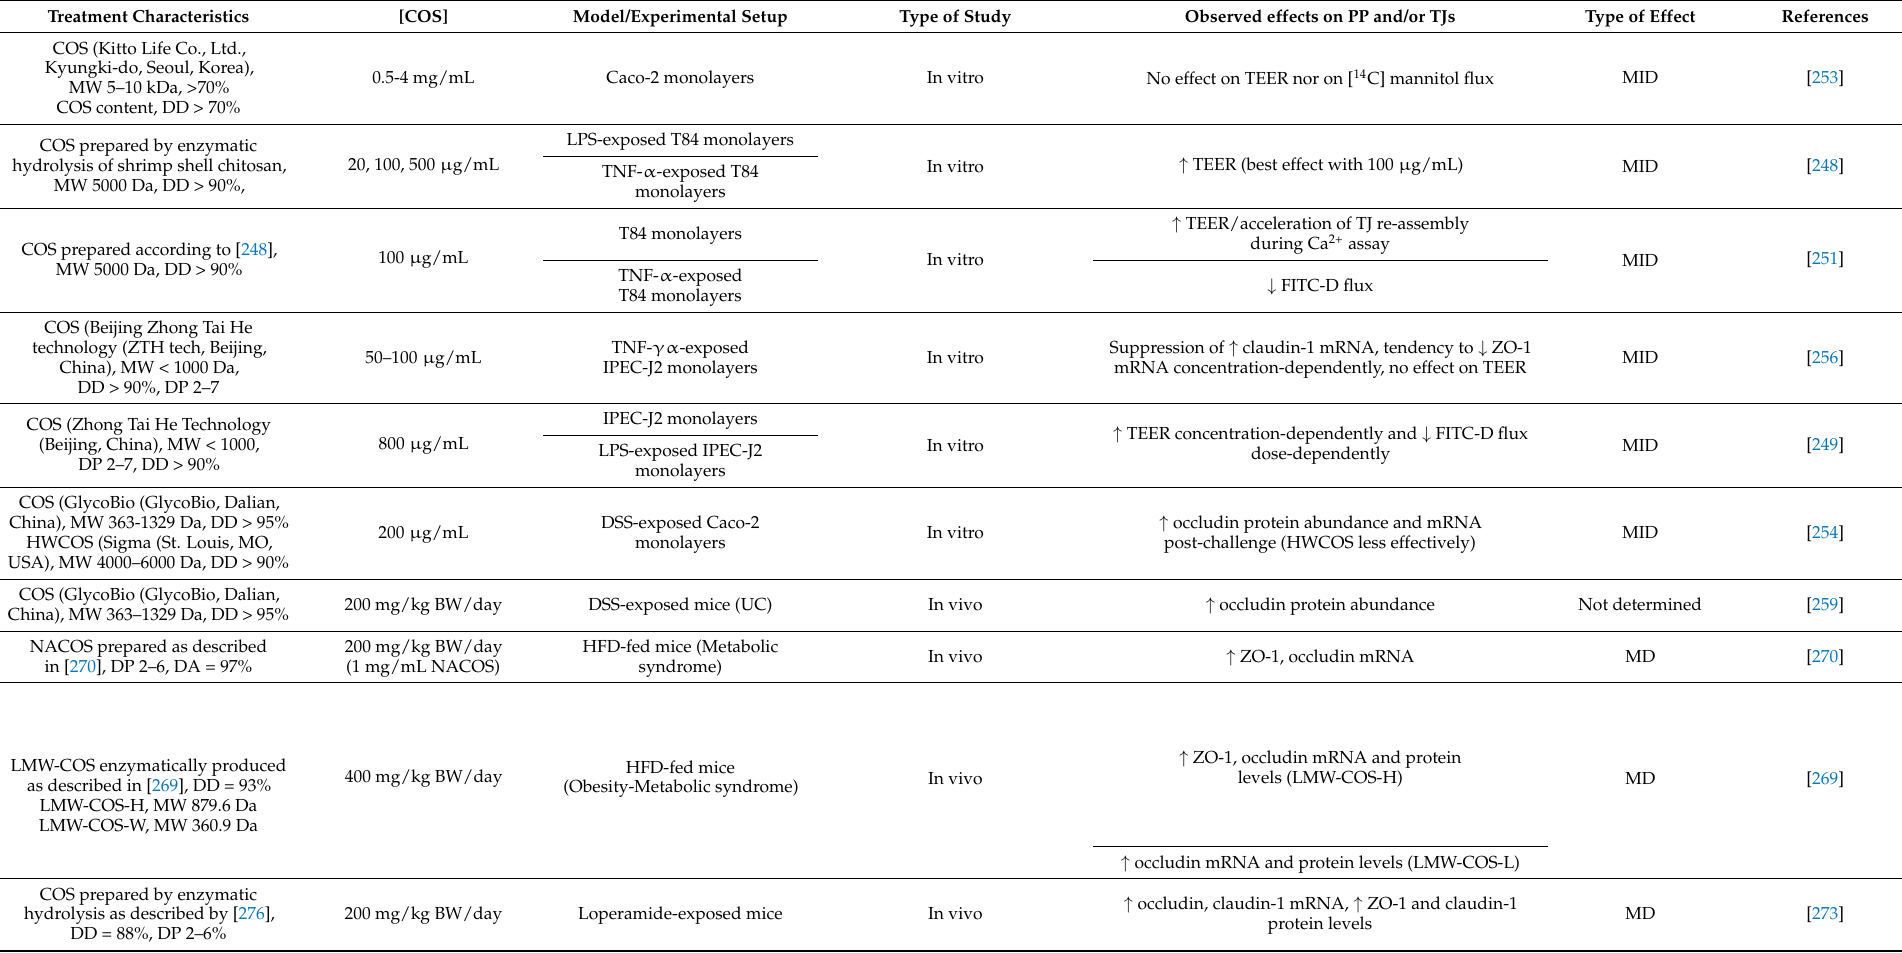
Table 4. Microbiota-dependent and independent effects of COS on paracellular permeability and/or